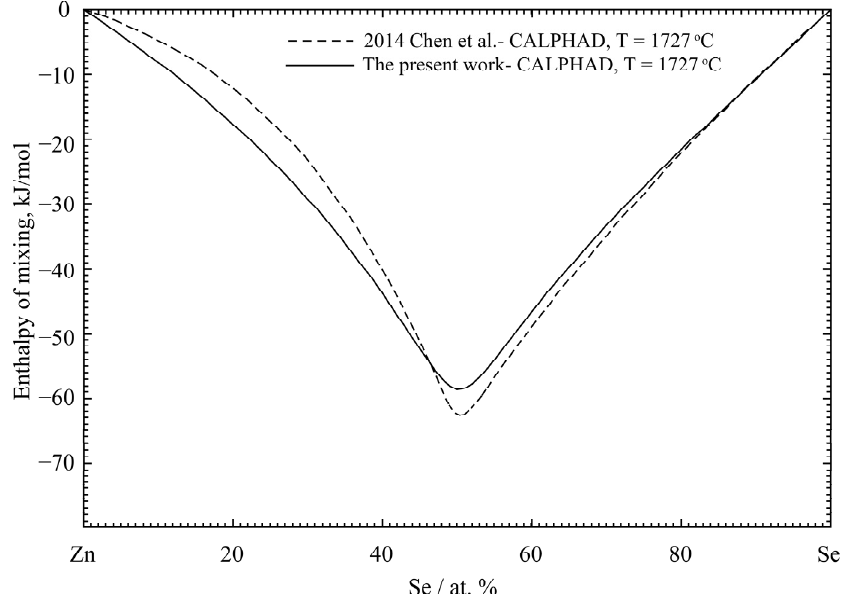
Figure 18. The calculated enthalpy of mixing at 1727 °C in the Zn-Se system compared with previously optimized results by Chen et al. [125].